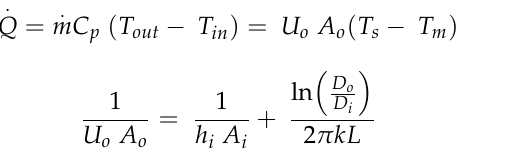
Figure 17. Variation of collector efficiency using water and hybrid nanofluids against daytime.